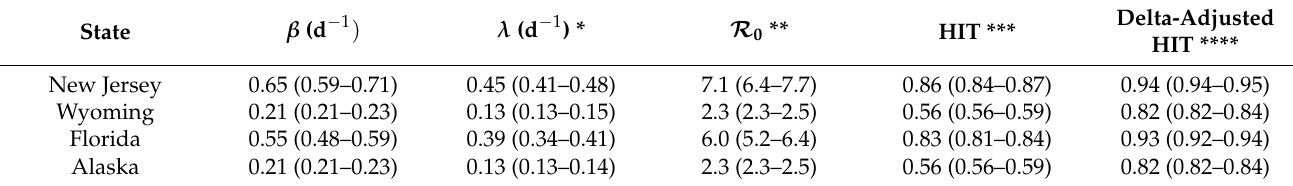
Table 1. Maximum a posteriori (MAP) estimates and 95% credible intervals for epidemic parameters ( β , λ , R 0 , HIT, and Delta-adjusted HIT) for the states of New Jersey, Wyoming, Florida, and